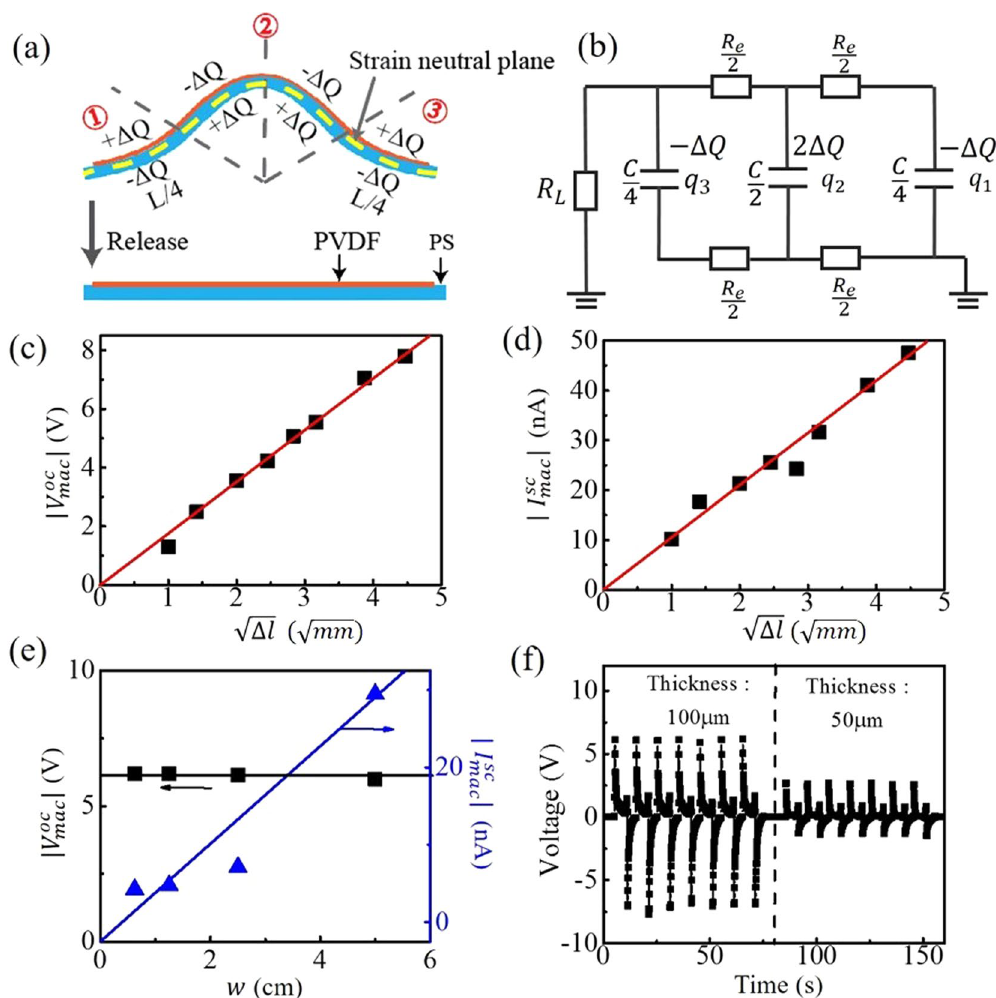
circuit voltage − ∆ ~ V t V e ( ) oc maxoc 2 t toc and the short circuit currents − ∆ ~ I t I e ( ) sc maxsc 2 t tsc with the following maximal values of the open circuit voltage and short circuit currents, as well as equilibration times Δ t oc , and Δ t sc : where the time constant is defined as: According to ref. 26, fixed charges Δ Q induced on the surface of a piezoelectric mat of length l /4 (see Fig. 4a) can be calculated as: